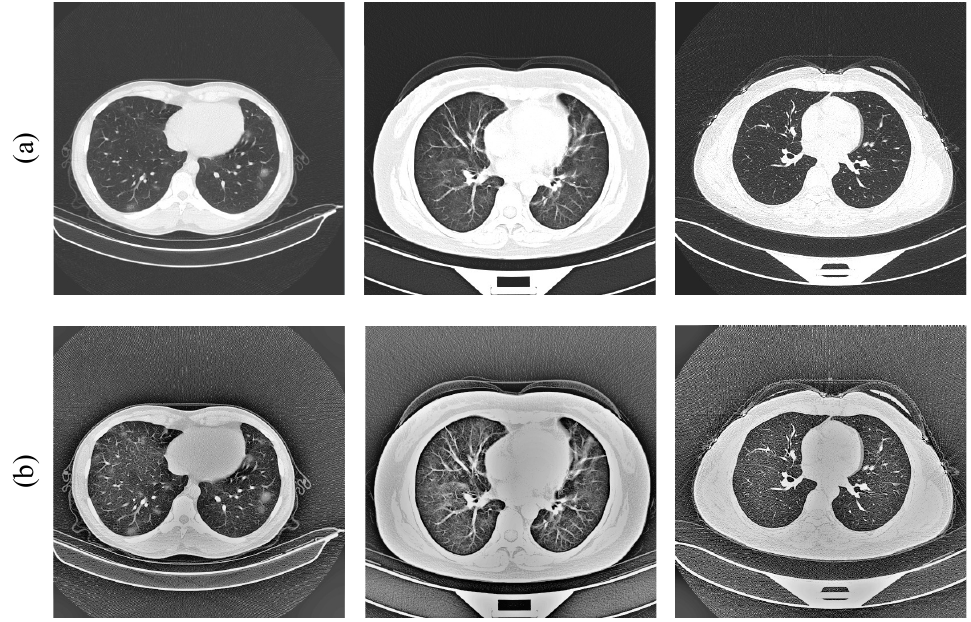
Figure 3. ( a ) Original images; ( b ) processed images [11,12].